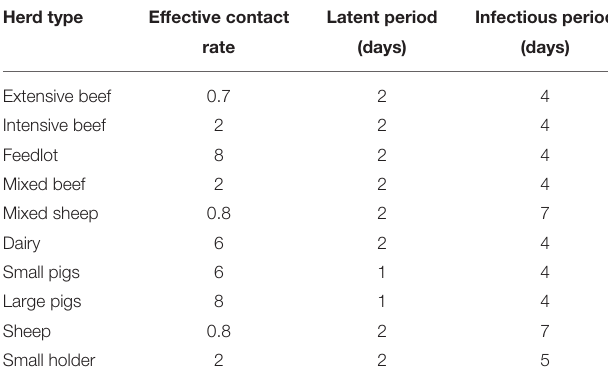
TABLE 2 | Selected EBM ODE